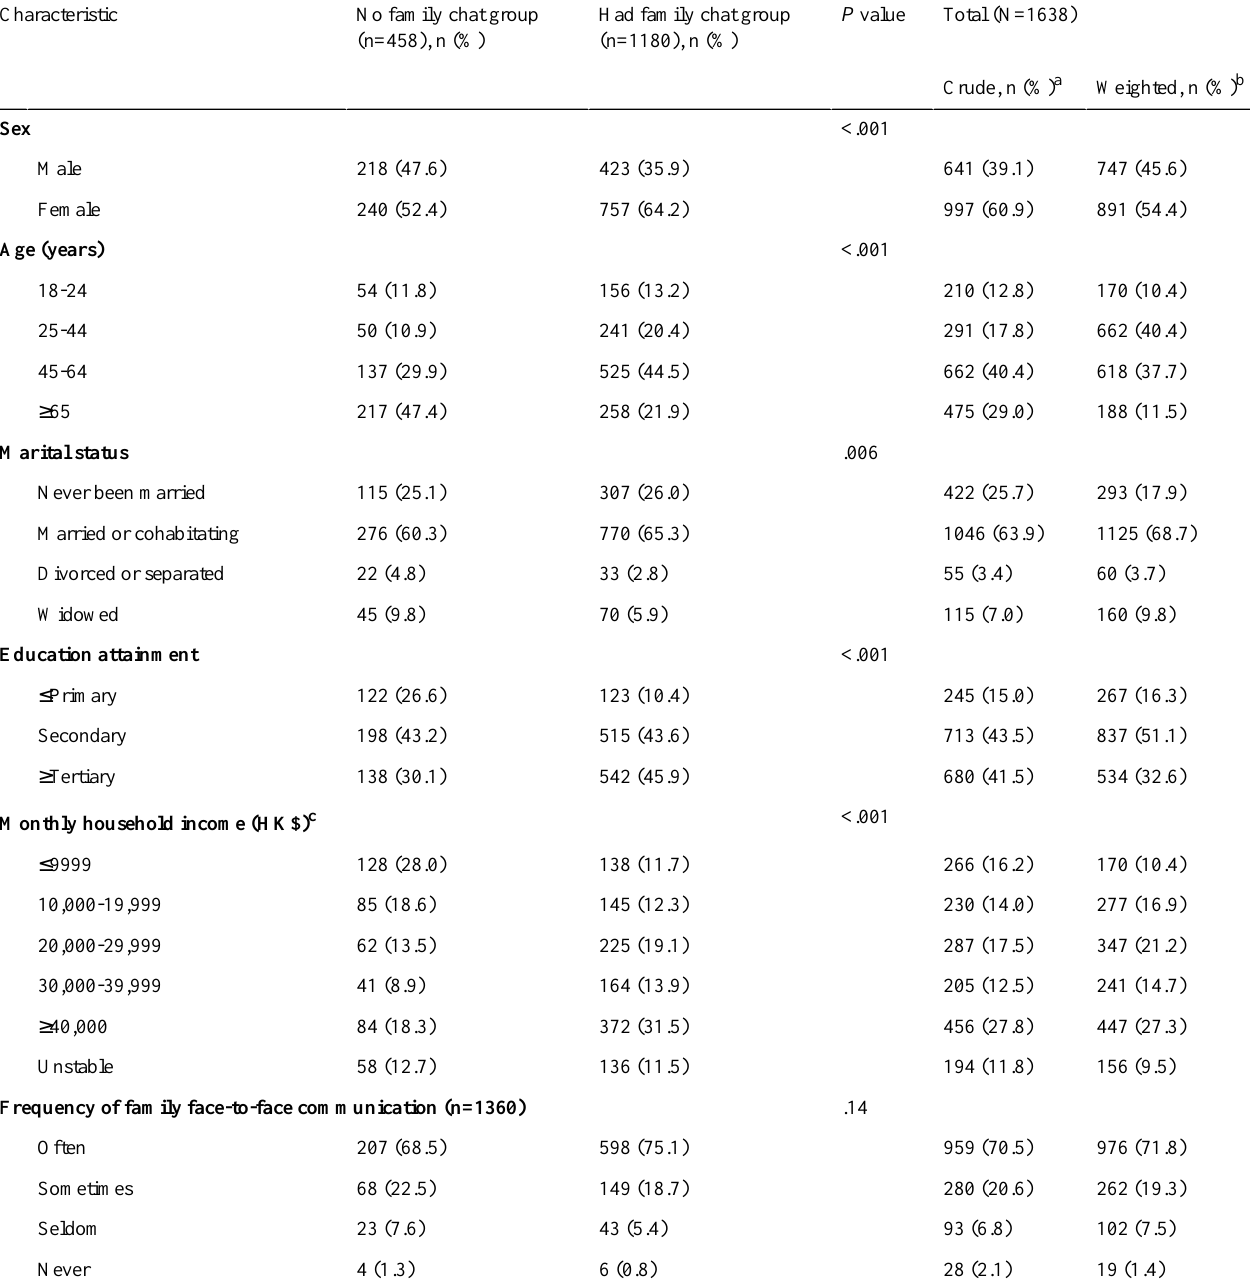
Table 1. Sociodemographic characteristics according to family instant message chat group